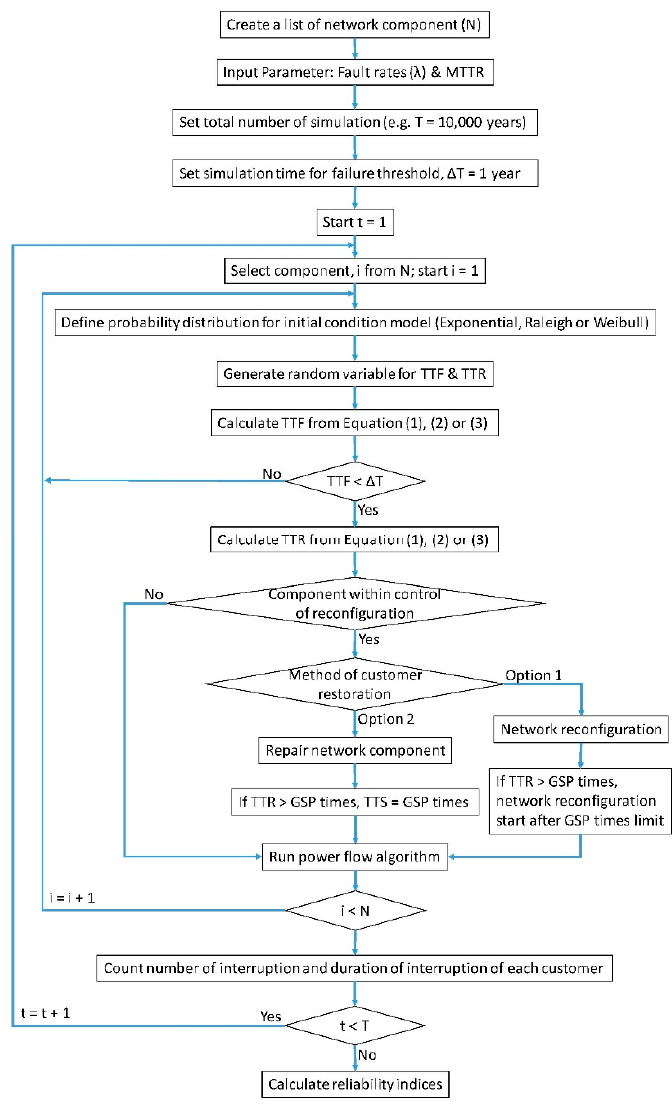
Figure 2. Monte Carlo simulation (MCS) procedures.